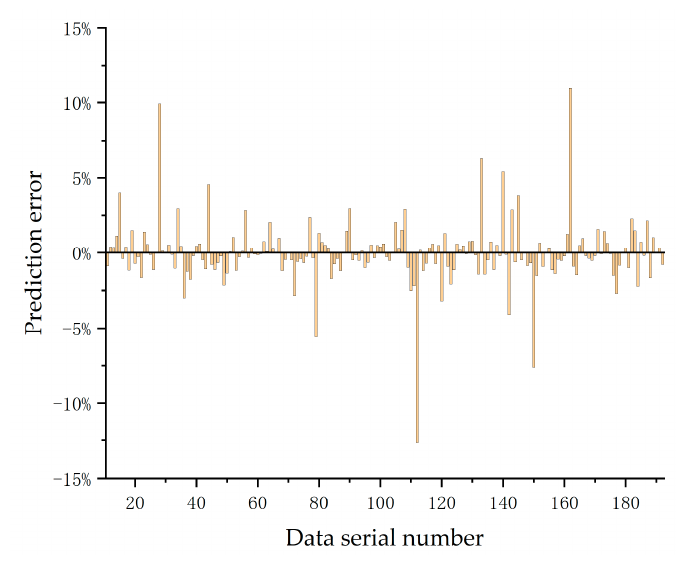
Figure 16. Prediction error.